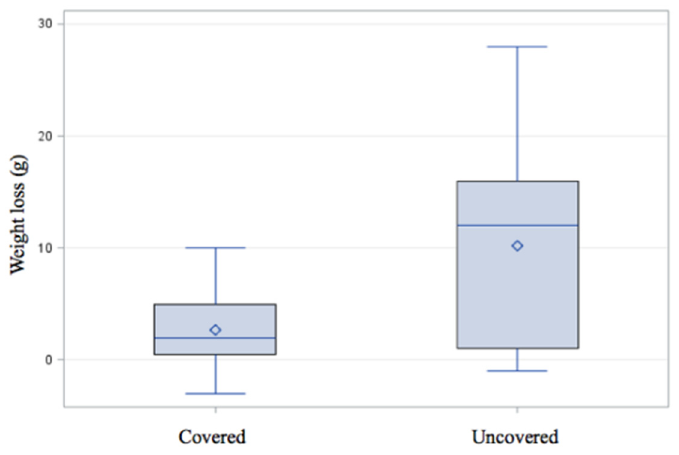
Figure 8. Weight loss in uncovered (control) and Reflectix™ covered pallets of amaranth after six hours storage at ambient